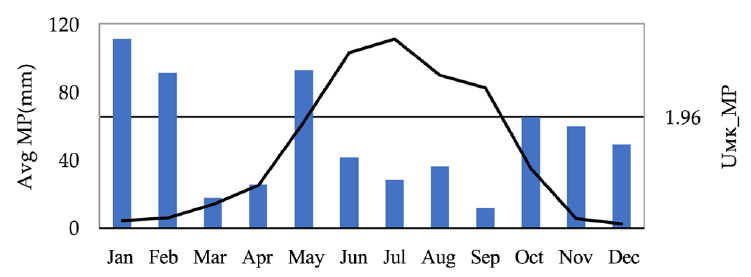
Figure 5. The average of regional mean monthly precipitation and the M–K test statistic during 1979– 2015 in the SRYR.